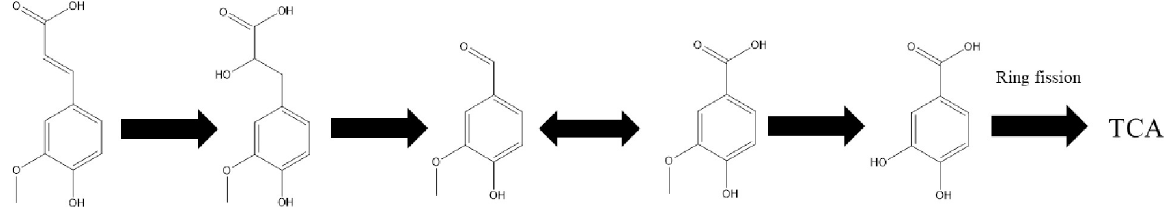
Fig 8. Speculated biodegradation pathways of ferulic acid and vanillic acid by marine bacteria.